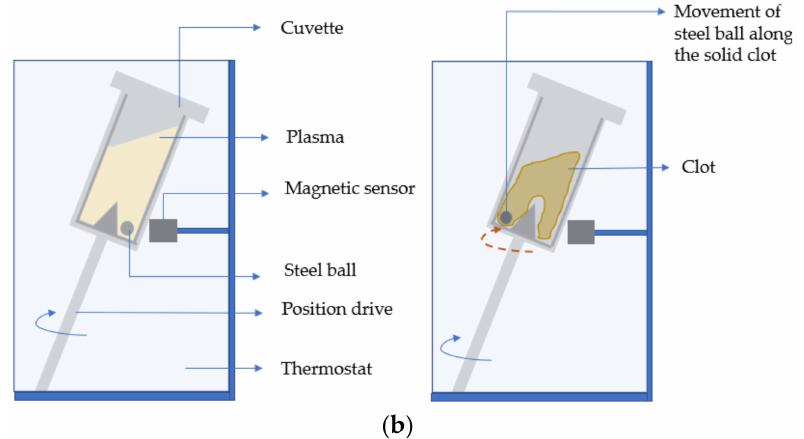
Figure 5. Schematics illustrating the conventional mechanical steel ball-based form of coagulation detection methods: ( a ) change in range of motion of magnetic steel ball and ( b ) break-in contact of steel ball with the magnetic sensors.